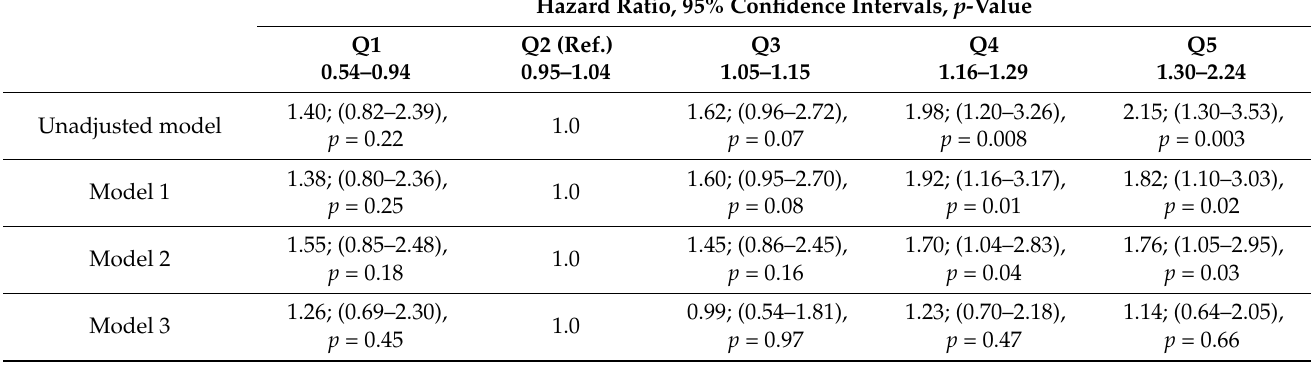
death in a group with the lowest sP was not different from the reference. The cubic-spline modelling of an unadjusted relation between sP and mortality is presented in Figure 4. Table 2. The risk of all-cause mortality related to increasing levels of sP in unadjusted model and in models adjusted for various clinical and laboratory variables.